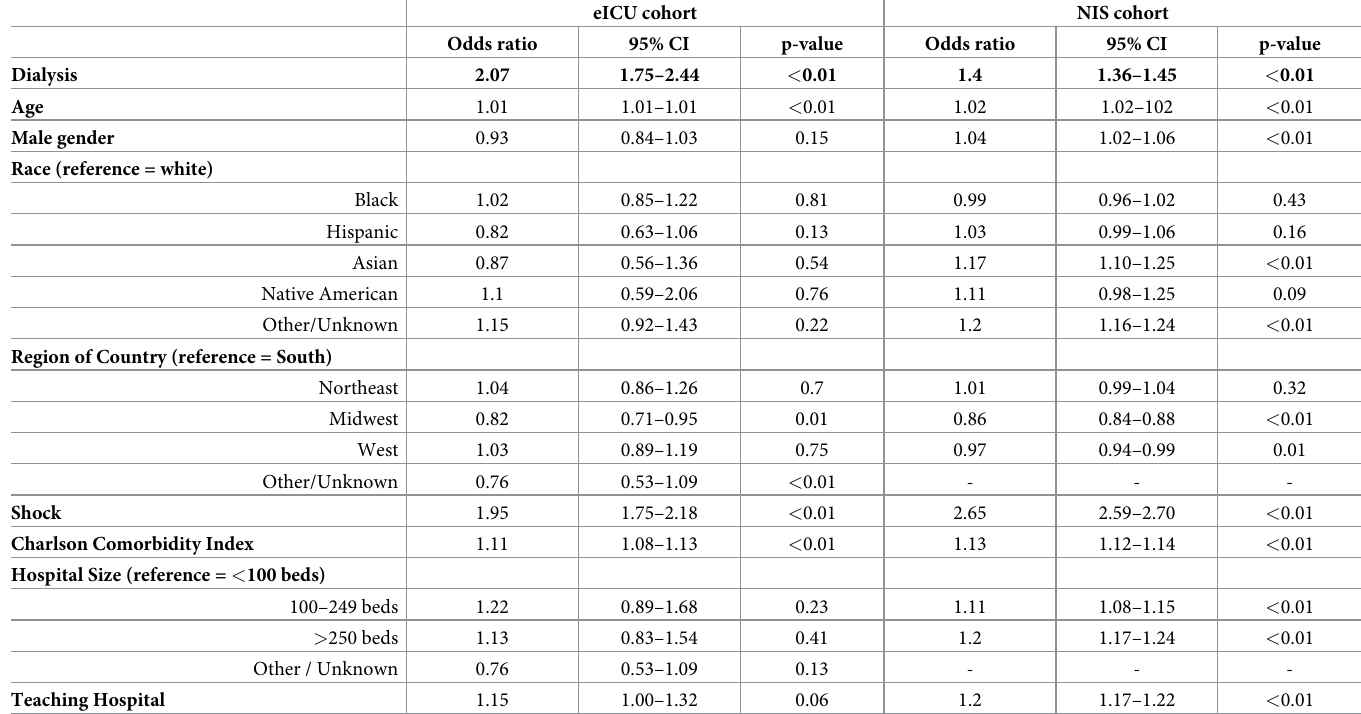
Table 2. The low resolution multivariable logistic regression model predicting in-hospital mortality in the NIS and eICU